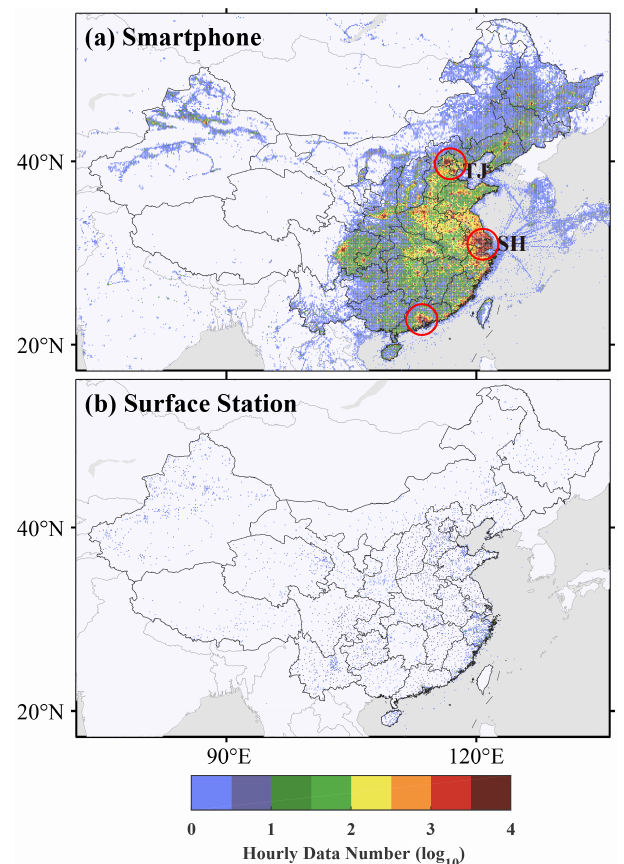
Figure 4. (a) Hourly pressure observation counts (log10 trans- formed) averaged over the year 2016. (b) Same as (a) but for the Chinese Meteorological Administration (CMA) surface stations. Data are binned into a 0.1 ◦ × 0.1 ◦ grid in (a) and (b) . The location of the port of Shanghai and the port of Tianjin are labeled as “SH” and “TJ” in (a) . The red circles indicate the urban agglomerations of (from north to south) Beijing–Tianjin–Hebei region, Shanghai and nearby cities, and Guangzhou and nearby